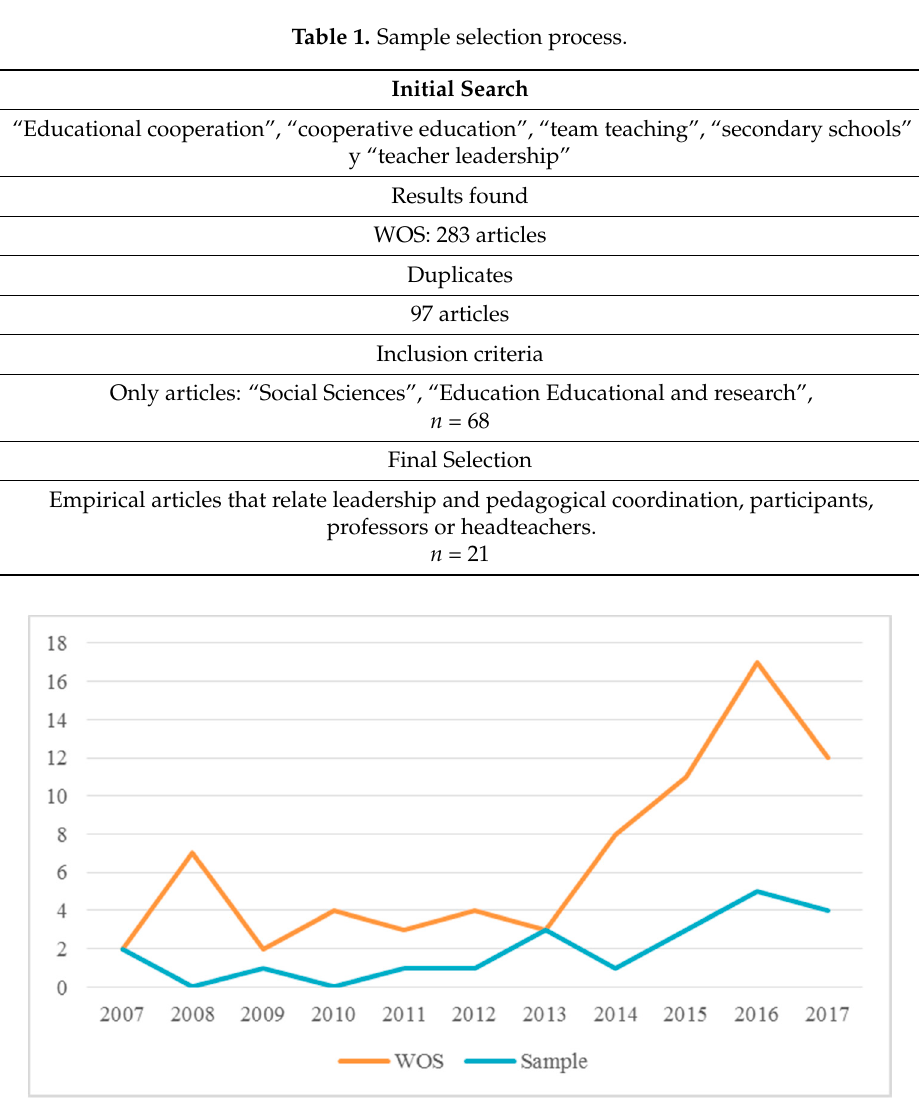
Figure 1. Distribution of publications from 2007 to 2017.